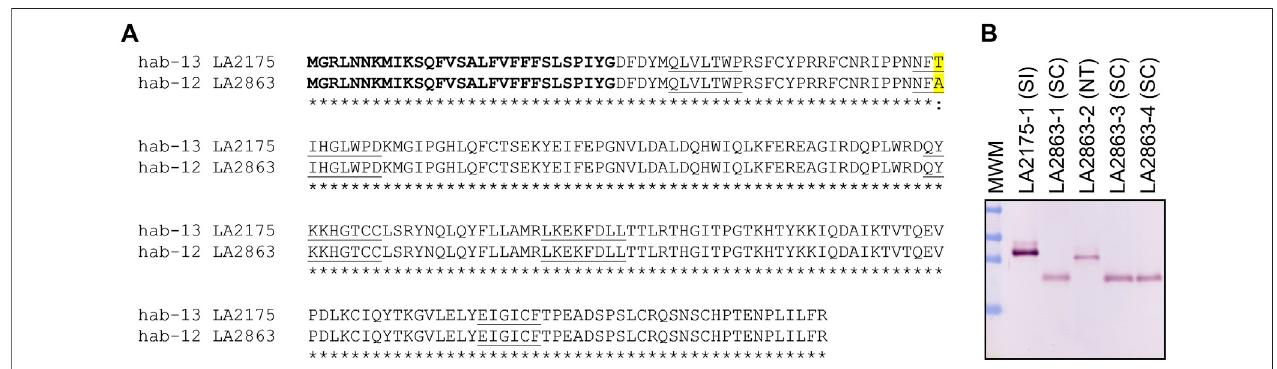
FIGURE 6 | Alignment and immunoblot of hab-12 S-RNase. (A) Deduced amino acid sequences of hab-12 (GenBank OK091161) and hab-13 (GenBank OK091162) from SC accession LA2863 and an SI plant from MP accession LA2175, respectively. A shorter but identical hab-13 sequence was identi fi ed in MP accession LA1391 (not shown). The predicted signal peptide is bolded, the single amino acid substitution is highlighted in yellow and conserved sequences C1-C5 are underlined. Asterisks indicate conservation between both sequences. (B) Immunoblot of stylar extracts using the tSRNC2 antibody raised to the conserved C2 region of S-RNases. MWM, molecular weight marker; SI, self-incompatible; SC, self-compatible; NT, mating system not